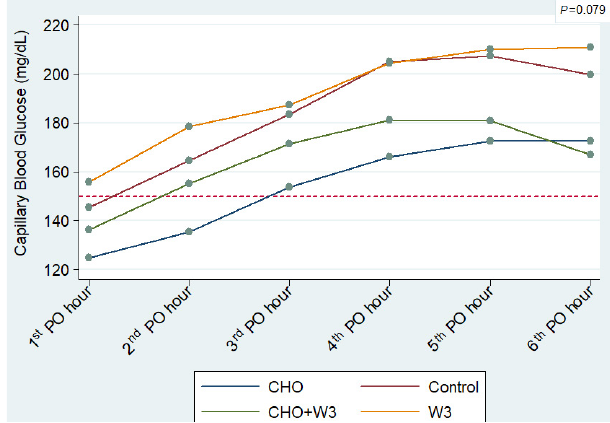
Fig. 5 - Average capillary blood glucose levels during the first 6 postoperative hours in the ICU, according to groups. Note: the dotted line indicates the 150 mg/dL limit and the regular use of exogenous insulin.